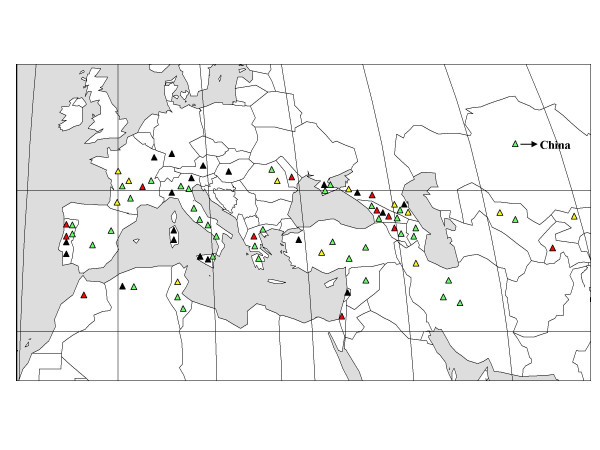
Probable geographic origin of the varieties contained in the nested genetic core collections. Each triangle corresponds to one variety, red triangles correspond to the first sub-sample of the nested genetic core collection (G-12), yellow triangles to the second sub-sample (G-24), black triangles to the third sub-sample (G-48) and green triangles to the fourth sub-sample (G-92). Ten varieties belonging to the Core G-92 did not have a precise geographical origin and are not shown on this map.